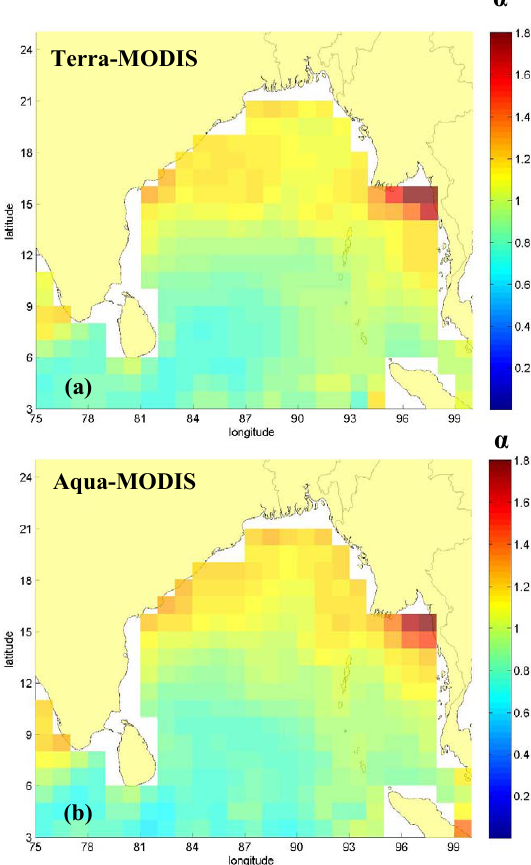
Fig. 10. Mean spatial distribution of Terra (a) and Aqua (b) MODIS AOD 550 over BoB during W-ICARB (27 December 2008–30 Jan- uary 2009). The MODIS data correspond to collection 5 (C005) Level 3 (1 ◦ × 1 ◦ ) .